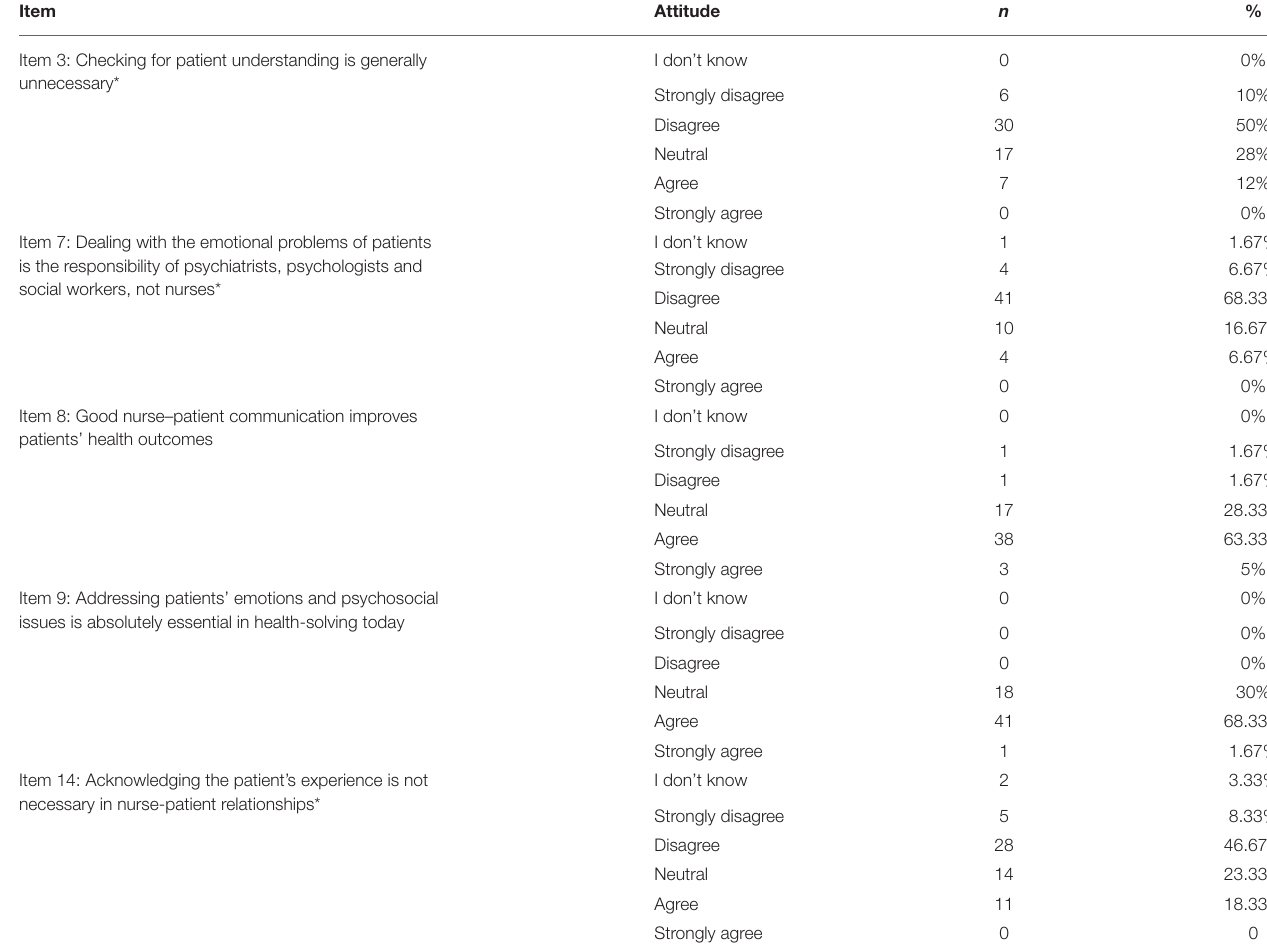
TABLE 5 | Percentages of each response for each item on perceived importance of engagement (Theme 1). Item Attitude n